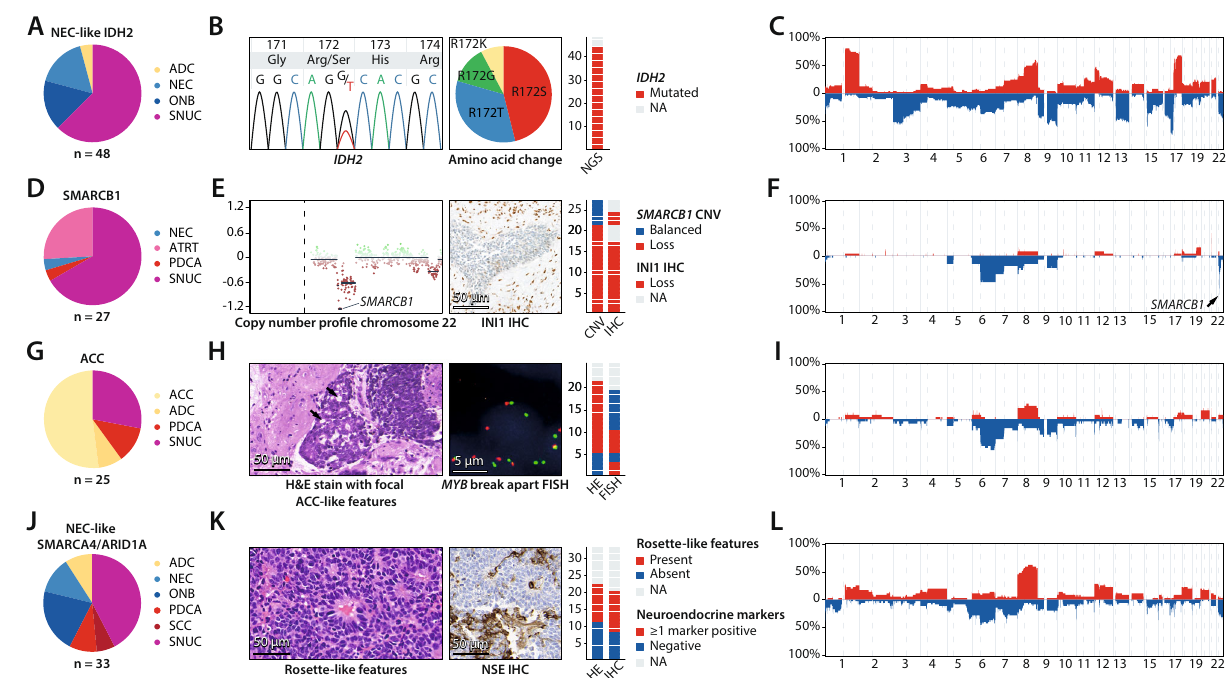
Fig.2|Reclassi fi cationofsinonasalundifferentiatedcarcinoma(SNUC)classes. A Piechartshowingtheconventionalhistopathologicaldiagnosisofcasesfromthe NEC-like IDH2 class. B Sanger-plot showing an example of an IDH2 c.516G>T (R172S)mutation.ThefrequenciesofR172S,R172T,R172GandR172Kmutationsare displayedasa piechart. A bar chart shows the frequency of R172mutations, which occurred in all of the investigated cases. C Summary copy number pro fi le of cases from the NEC-like IDH2 class showing highly recurrent copy number alterations such as gain of chromosome 1q as well as loss of chromosome 17p in combination withchromosome17qgain. D Piechartshowingtheconventionalhistopathological diagnosis of cases from the SMARCB1 class. E Detailed copy number plot of chro- mosome 22 with focal deletion of the SMARCB1 gene locus and subsequent loss of INI1expressioninimmunohistochemistry. F Summarycopynumberpro fi leofcases fromtheSMARCB1class,the SMARCB1 genelocusishighlightedbythearrow. G Pie chart showing the conventionalhistopathological diagnosisofcasesfrom the ACC class. H Exampleof histomorphologicaland molecularevidenceforadenoid cystic